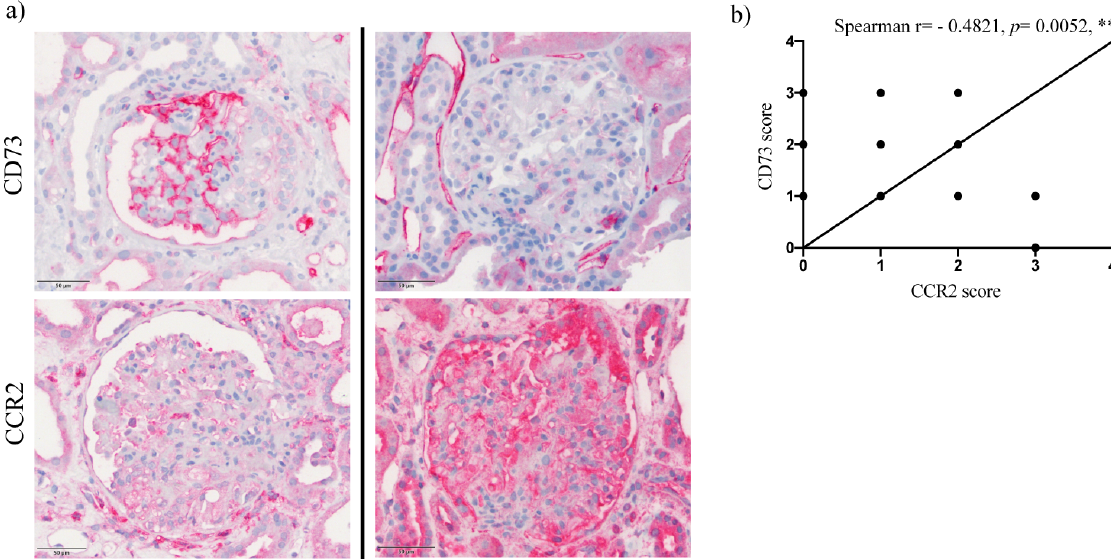
Figure 4. Correlation between podocyte CD73 and CCR2 expression by immunohistochemistry. ( a ) Photomicrographs showing immunohistochemistry for CD73 (upper row) and CCR2 (lower row) in two cases of MCD (left and right column). Stronger expression of CD73 is associated with milder positivity for CCR2 in podocytes, but also in surrounding cellular milieu (for example, parietal epithelial cells), 40×/0.65 NA. Scale bar = 50 µm. ( b ) Scatter plot with bars showing negative correlation between CD73 (squares) and CCR2 (triangles) intensity scores in podocyte damage groups (data are presented as mean ± SEM). The correlation was assessed by Spearman non-parametric correlation test (Spearman r = − 0.4821; two-tailed p = 0.0052; ** significant negative correlation).